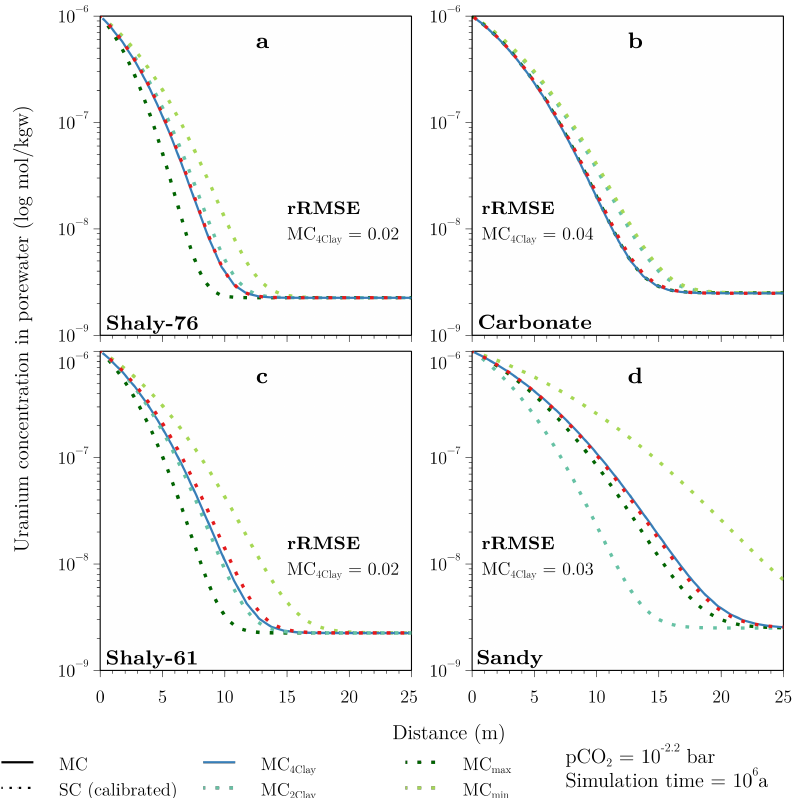
Figure 6. Concentration of uranium in the porewater of the shaly ( a , c ), carbonate-rich ( b ) and sandy facies ( d ) for the scenarios with minimum (MC min , light, green line), maximum (MC max , dark, green line) and average (MC, blue line) total amount of rock per kg porewater as well as for the concepts considering four (MC 4 Clay ) and two clay minerals (MC 2 Clay ) for sorption. Dotted lines mean that the SC approach with the calibrated K d and D e was used, with red representing the results for the MC 4 Clay scenario for better visibility. Only MC 4 Clay (blue line) is based on the MC diffusion